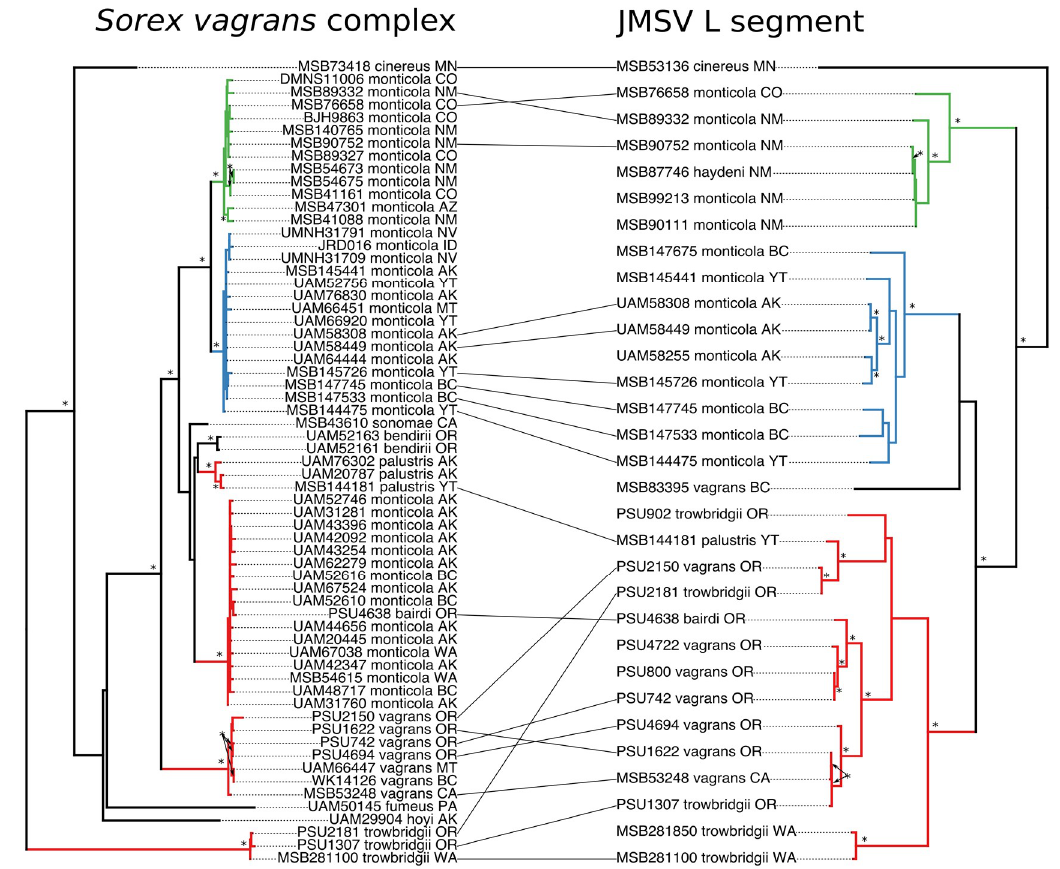
Figure 3. Tanglegram for Sorex vagrans complex on the left, and Jemez Springs virus L segment on the right. Host individuals and their associated virus strains are illustrated with a black line. Color-coded branches correspond to geographic clades of the virus: Green = Southern Continental; blue = Northern Continental; red = Pacific Coastal. State abbreviations are as shown in Figure 2. Bootstrap support values greater than 70% are indicated with an asterisk.